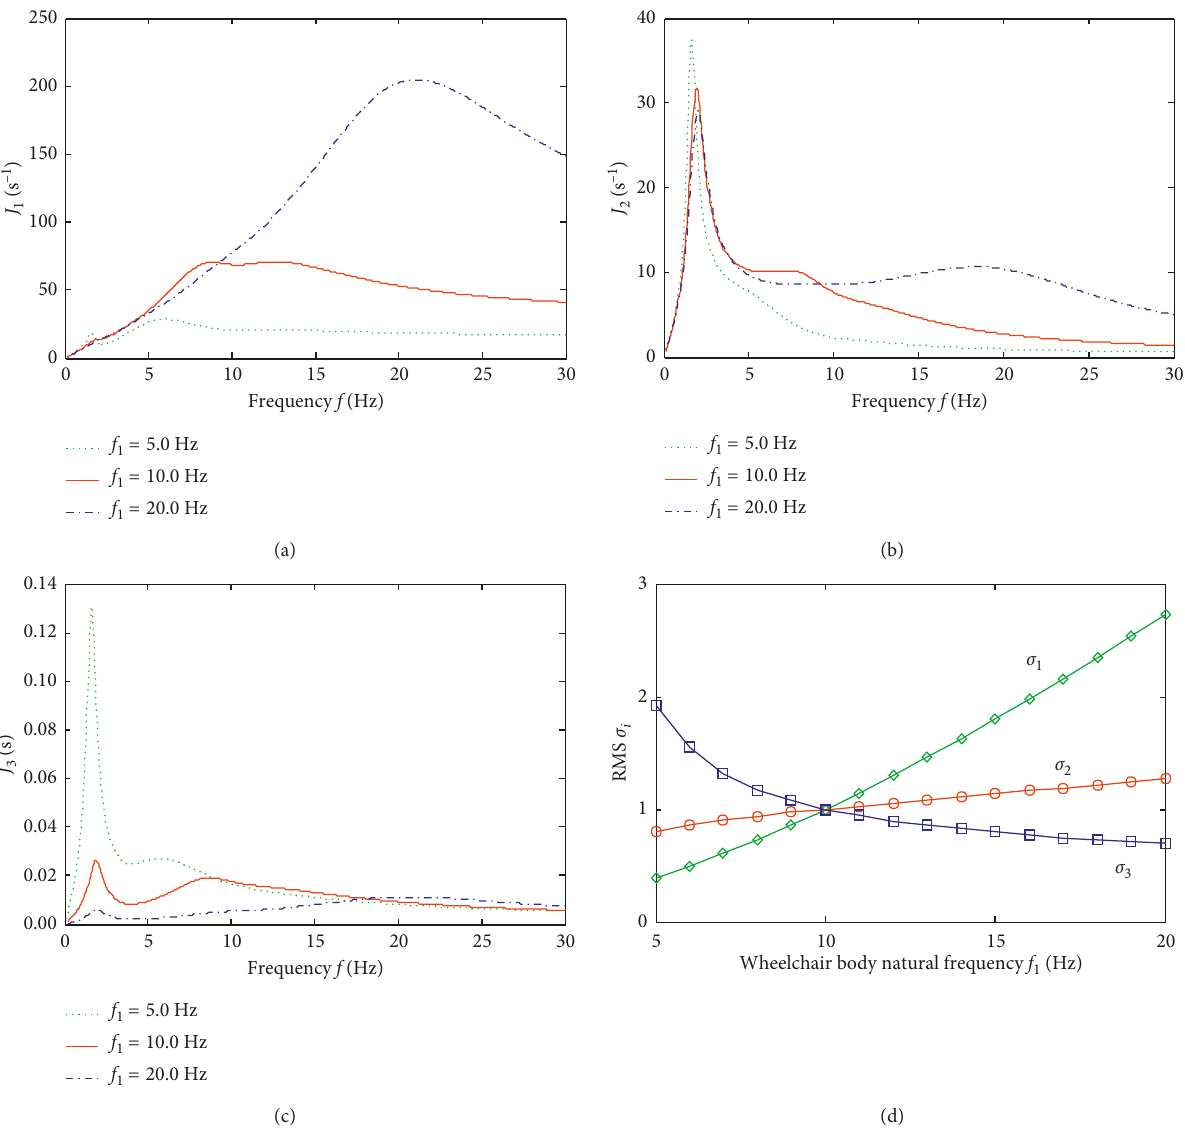
Figure 10: Influences of f on € z , € z , and f : (a) the amplitude frequency characteristics J 1 1 2 d frequency characteristics J at different values of f ; (c) the amplitude frequency characteristics J 2 1 , and σ versus f σ 2 3 1